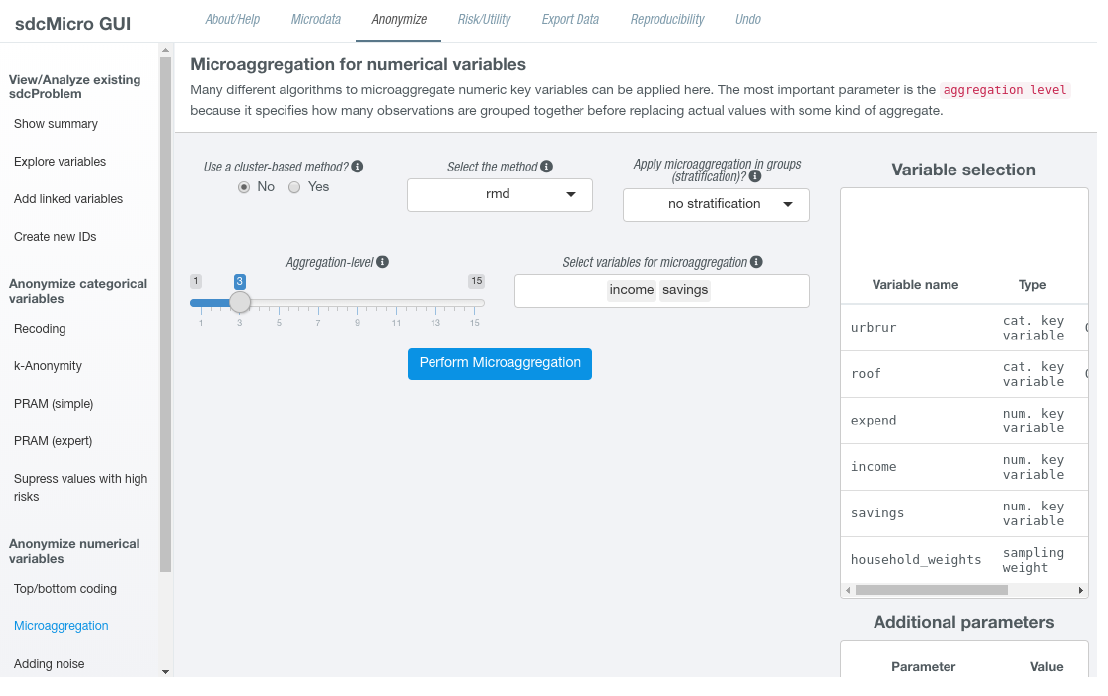
Figure 3. Screen to set up microaggregation in the